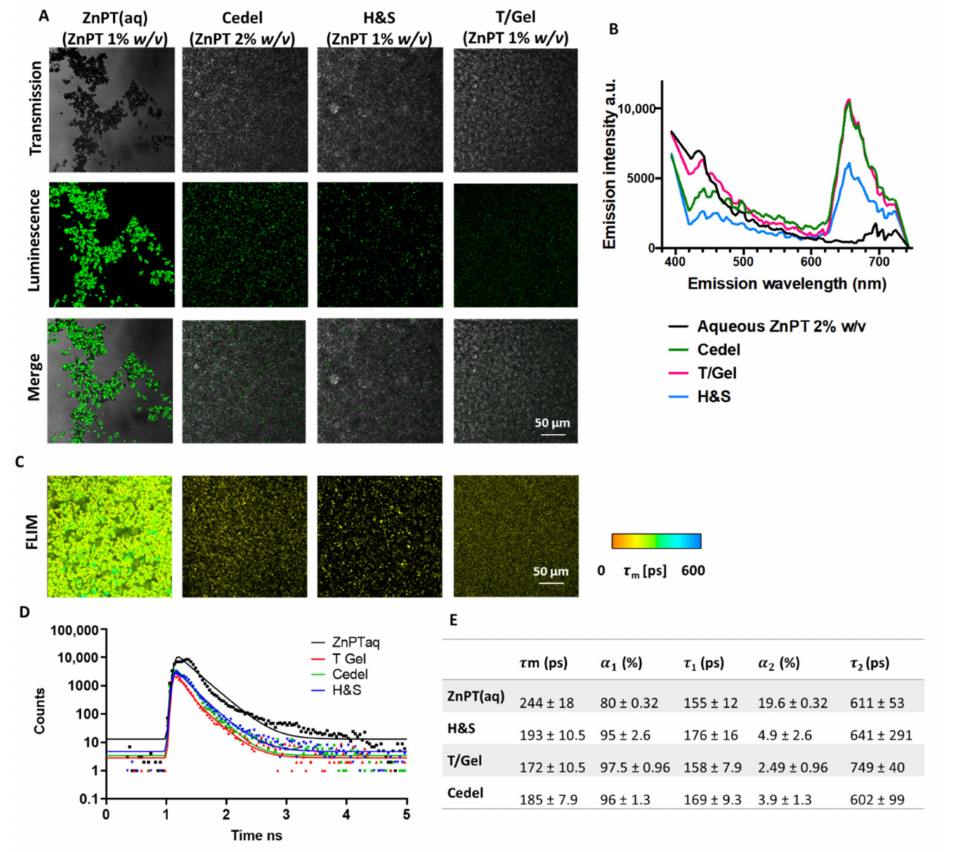
Figure 1. Spectral and lifetime characterisation of ZnPT particles in formulation . ( A ) Transmis- sion, luminescence (at 800 nm excitation, emission 395–420 nm) and merge-mode images obtained using 40 × objective. ( B ) Spectral emission scan at 800 nm excitation of formulations. ( C ) FLIM images (405/20 nm emission) with ( D ) corresponding decay curves and ( E ) lifetime parameters. τ m, average time-weighted lifetime; α 1 , relative-amplitude component of fast-decay component; τ 1 , fast-decay lifetime; α 2 , relative-amplitude component of slow-decay component; τ 2 , slow-decay